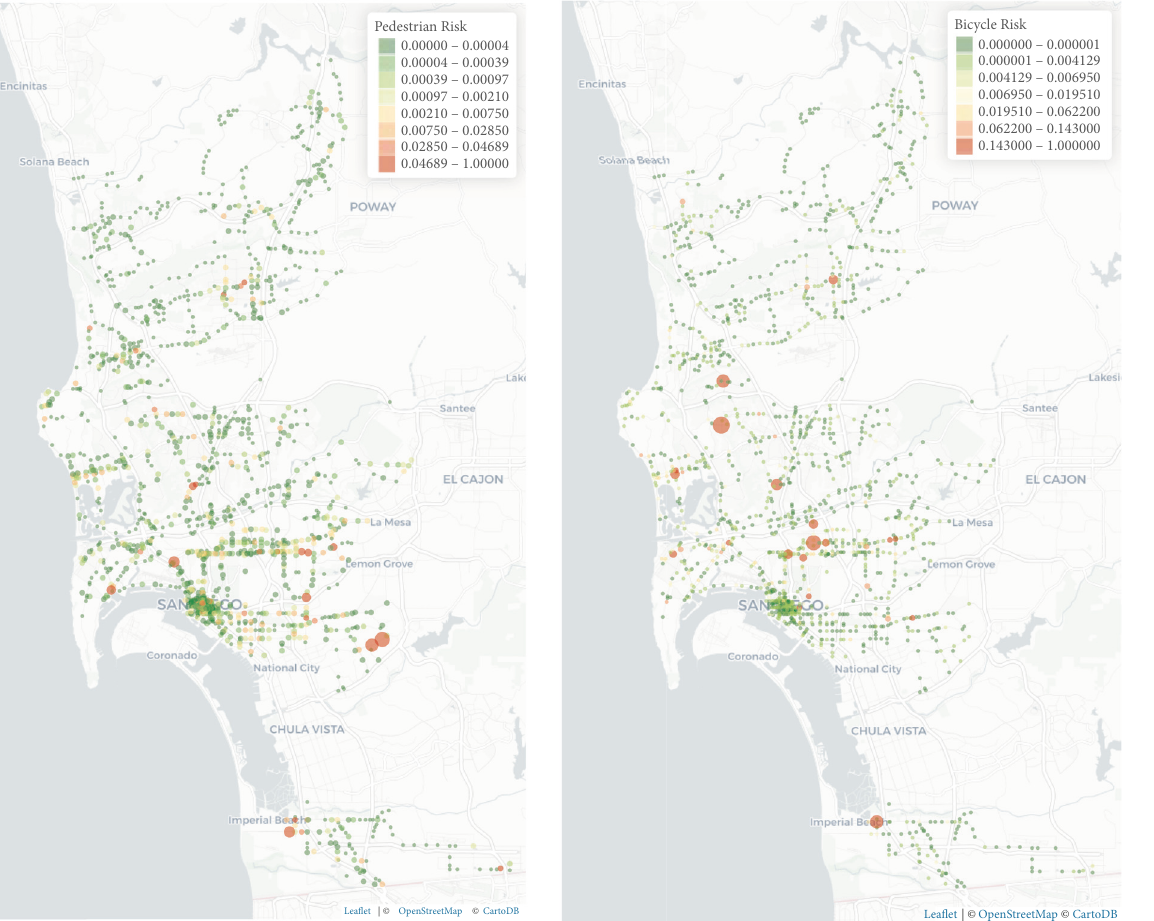
Figure 8: High-risk intersections for walking (left side) and bicycling (right